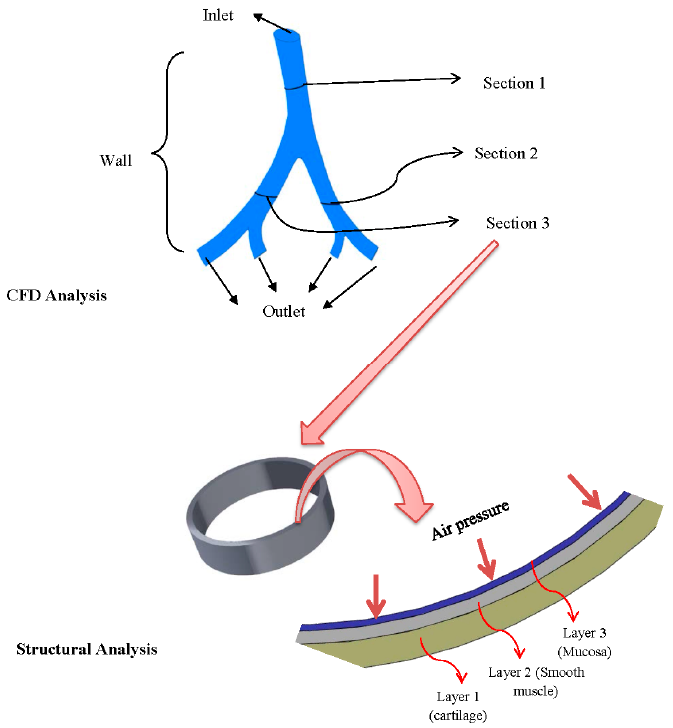
Figure 1. Multi-level analysis adopted for transient mechanical response of airway lung tissue. Top : model and boundary condition used for fluid flow analysis. Bottom : model for mechanical analysis.